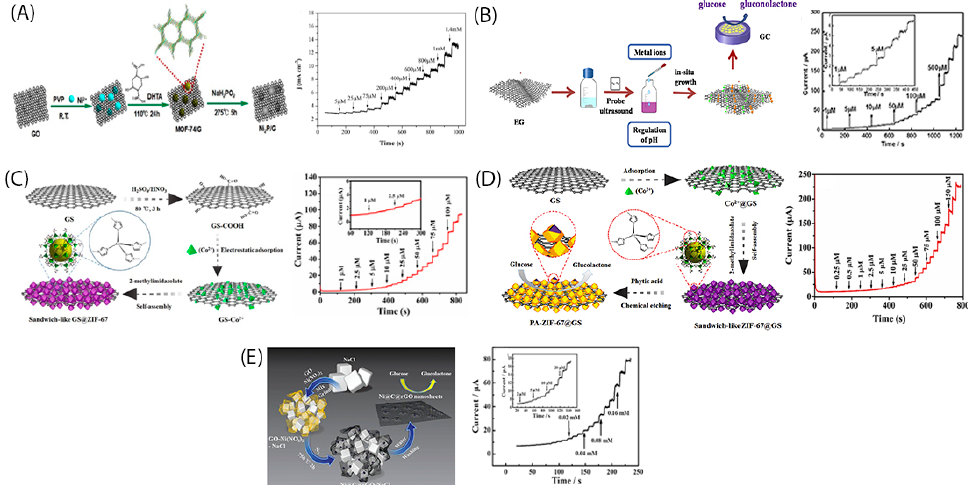
Figure 2. ( A ) In-situ synthesis procedure of Ni 2 P/graphene and the respective amperometric re- sponse to glucose injection [61]; ( B ) In-situ synthesis process of a NiCo-MOF-exfoliated graphene electrocatalyst and the respective amperometric response to glucose injection [62]; ( C ) In-situ syn- thesis of graphene@ZIF-67 heterostructure and the respective amperometric response after the glu- cose injection [63]; ( D ) In-situ growth of MOF into physically exfoliated graphene, functionalized the used MOF (ZIF-67) using phytic acid [70] and ( E ) In-situ synthesis Ni@C@rGO nanosheets and the resulting amperometric response to glucose detection [34].